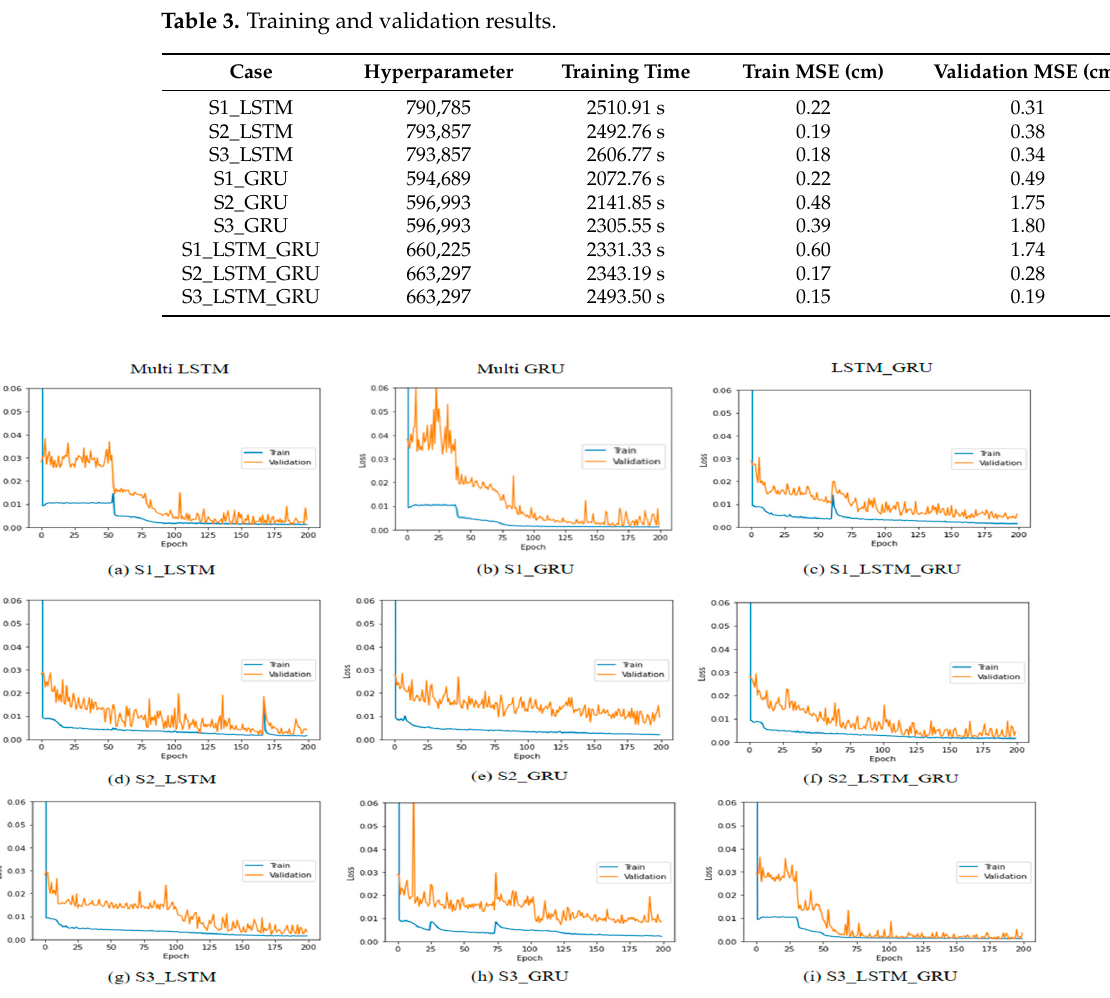
Table 4. Test results.